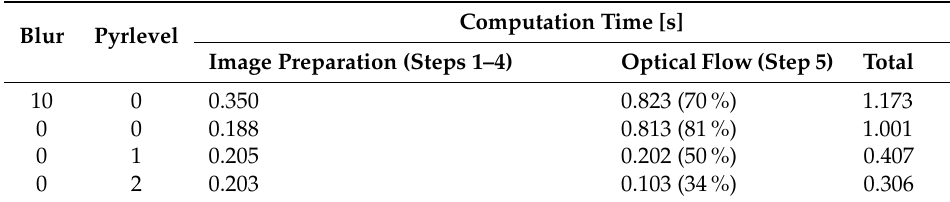
Table A1. Performance analysis of the five image preparation steps listed above, dependent on Gaussian pyramid level ( pyrlevel ) and Gaussian blurring ( blur ) including the relative percentage impact of the optical flow